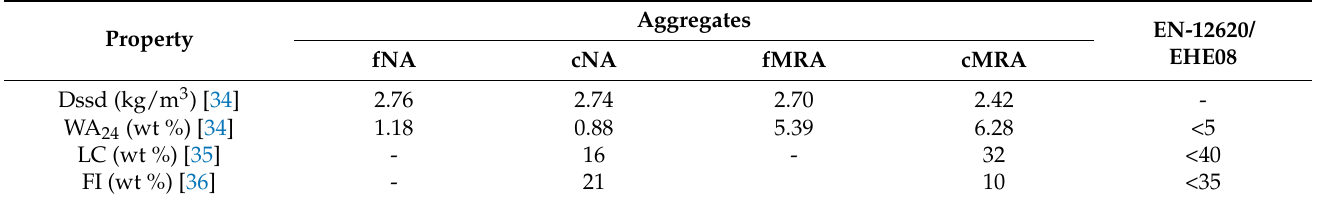
Table 2. Physical and mechanical properties of the aggregates.